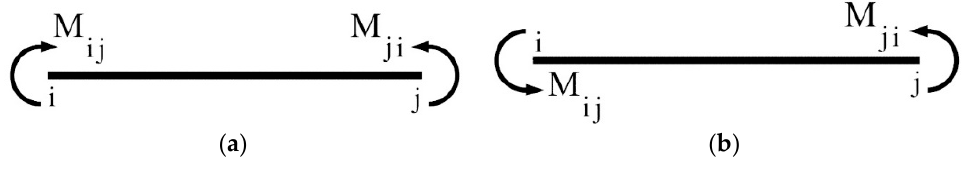
Figure 3 . ( a ) Positive directions in MIV; ( b ) positive directions in SDM. Figure 3. ( a ) Positive directions in MIV; ( b ) positive directions in A fi xed beam with both ends subjected to the distributed load is shown in Figure 2b.